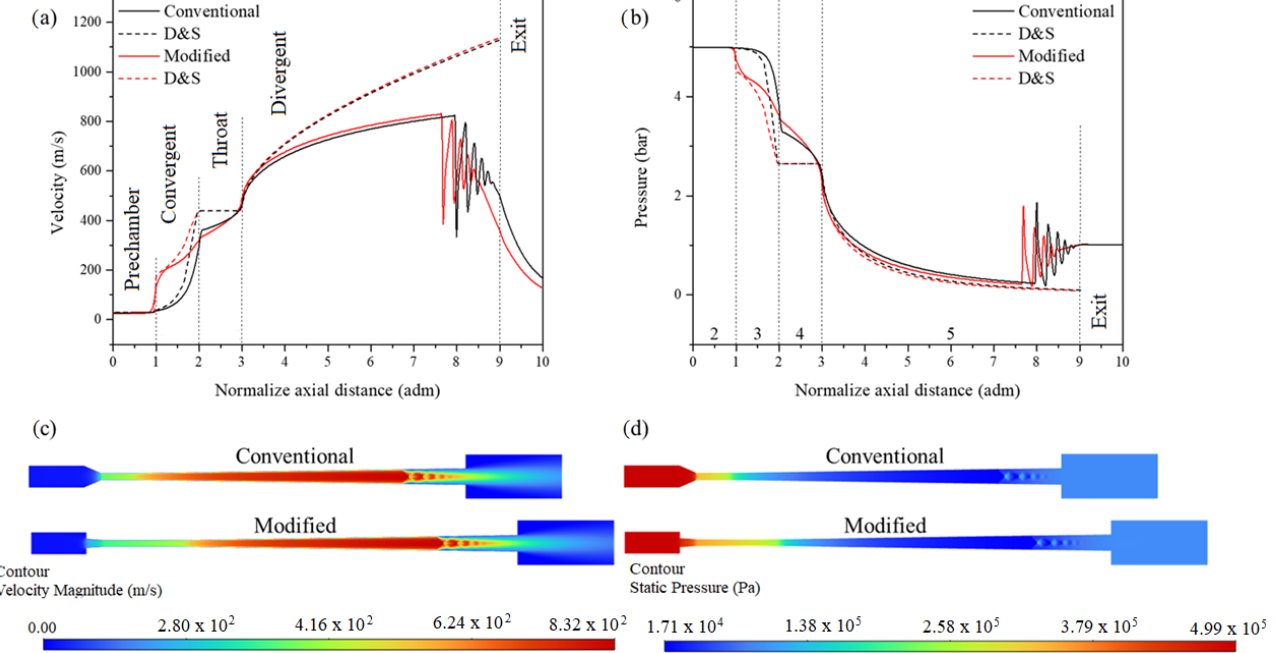
Figure 2. Velocity and pressure profiles for conventional and modified nozzles using CFD and 1D (D&S) models: ( a ) velocity, ( b ) pressure, and contour plots: ( c ) velocity and ( d ) pressure.